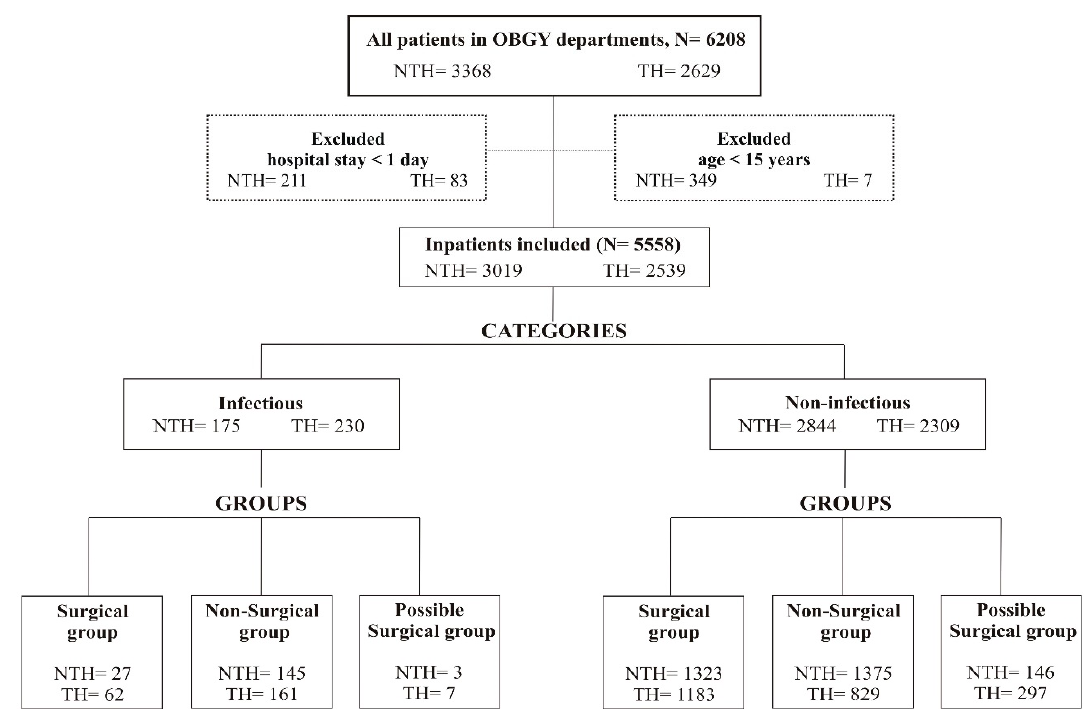
Figure 1. Patients’ categorisation based on the recorded indications in the Obstetrics and Gynaecology departments of two private-sector hospitals, the TH and the NTH in Central India Abbreviations: NTH = Nonteaching hospital; OBGY = Obstetrics and Gynaecology departments; TH = Teaching hospital. Table 1. Patient’s characteristics and antibiotic prescribing in the Obstetrics and Gynaecology departments of two private-sector hospitals, teaching (TH) and nonteaching (NTH), in Central India. Variables TH NTH Total number of patients 2539 3019 Age; mean years (SD) 34 (13) * 30 (11) Patients prescribed AB; n (%) 2044 (81) 2567 (85) * Duration of hospital stay; mean days (SD) 8 (9) * 3 (3) Duration of AB treatment; mean days (SD) 8 (7) * 5 (3) Total number of prescription days 30,616 12,512 Statistically significant values ( p < 0.001) are marked with *. Abbreviations: AB = antibiotics; NTH = Nonteaching hospital; OBGY = Obstetrics and Gynaecology departments; SD = standard deviation; TH = Teaching hospital.